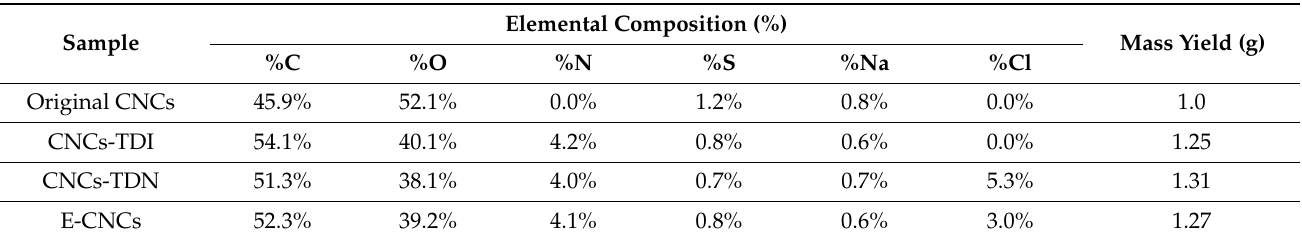
Table 1. The elemental composition of the CNCs and mass yield (starting with 1.0 g of CNCs) after carbamation using 2,4-TDI (CNCs-TDI), hydrolysis using HCl-acidified DMSO (CNCs-TDN), and polymerization using APS